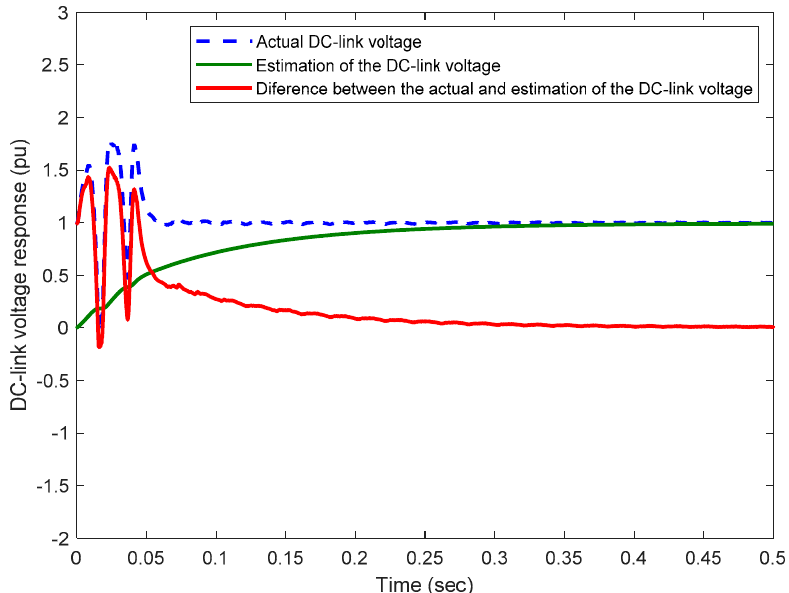
Figure 9. Convergence’s dynamics of the linear observer for the DC ‐ link voltage.